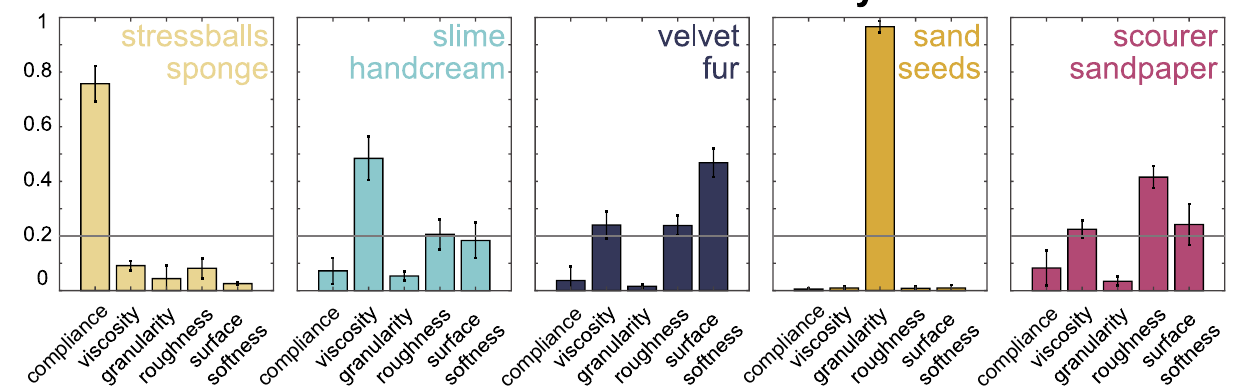
Figure 3. We show the performance of a support vector machine predicting the perceptual dimension from EP frequencies. The algorithm was trained on relative EP frequencies in order to predict the perceptual dimension that a new EP pattern is likely to belong to. Since the classifier was trained to discriminate between five classes, the chance performance level was at 20 percent (horizontal gray line). For each tested EP frequency type (where type refers to the perceptual dimension that the exploredmaterials scored high on) we also plot the confusions that the classifier generated.